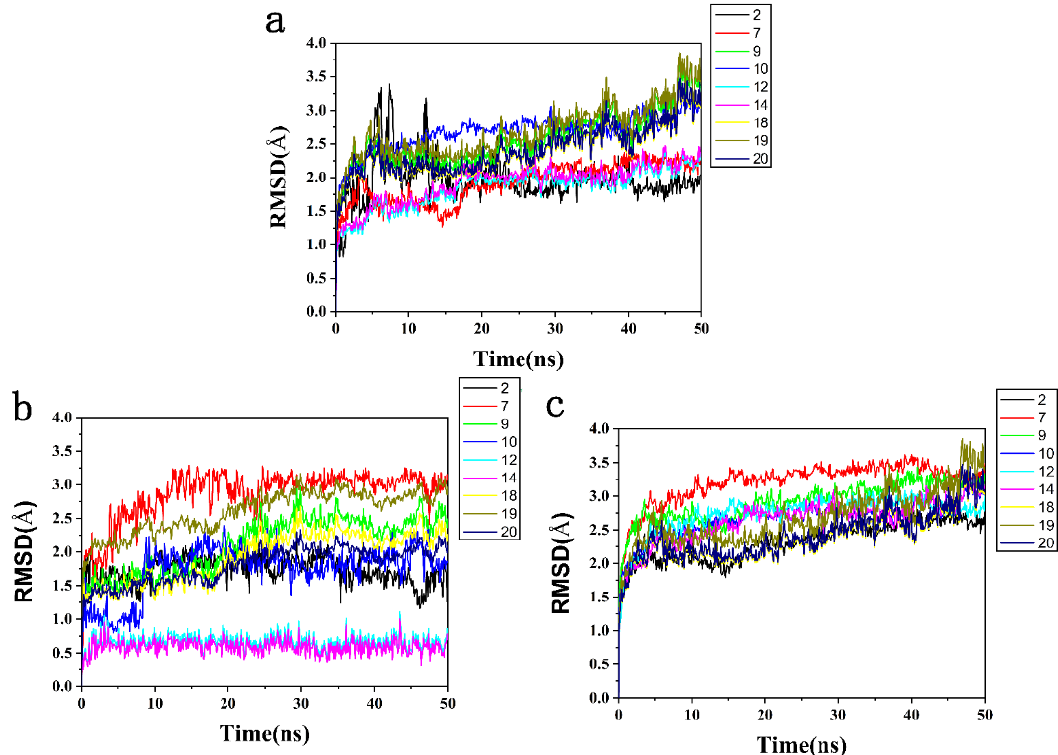
Figure 8. The RMSD trajectories of all systems during 50 ns simulations. ( a ) The protein active pocket with residues of 5 Å around ligand, ( b ) backbone Cα atoms and ( c ) heavy atoms of ligand- receptor.